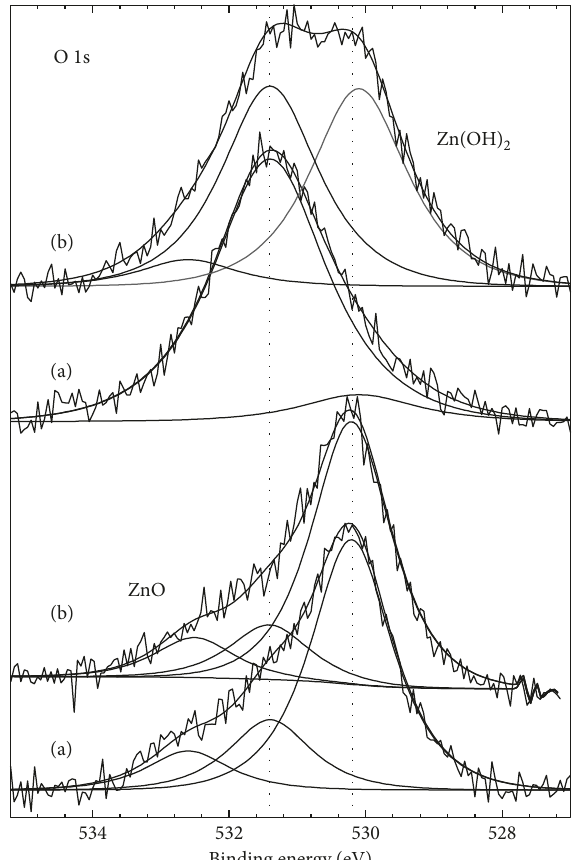
Figure 5: O 1s photoelectron spectra for ZnO and Zn(OH) (a) and after (b) Ar + sputter cleaning.